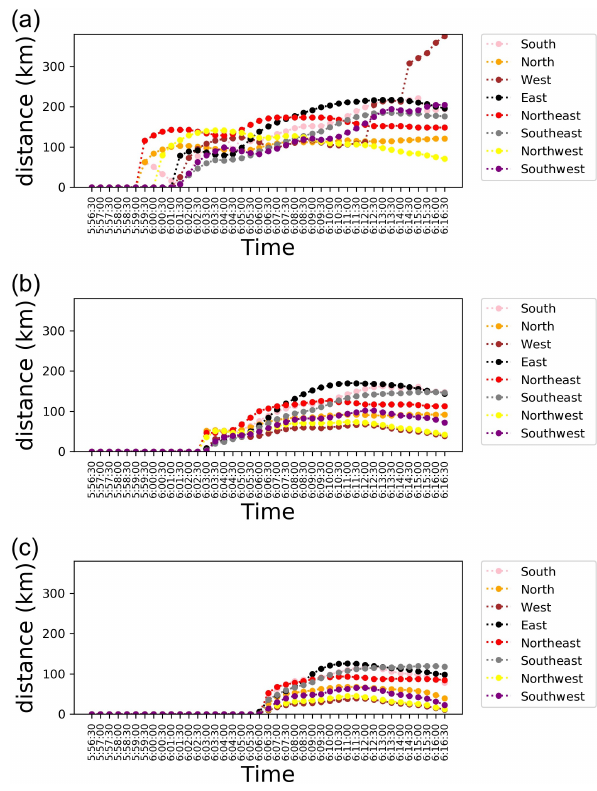
Figure 9. Expansion of the tsunami ionospheric hole. Panel (a) is the time series of the distance from the tsunami source in eight di- rections for the TIH with TEC less than or equal to − 2. Panels (b) and (c) are the time series of distance with TEC less than or equal to − 3 and − 4,